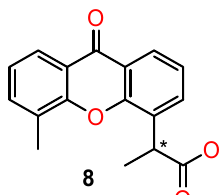
Figure 8. The structure of chiral analogues of dimethyl xanthone-4-acetic acid. * stereogenic centre.